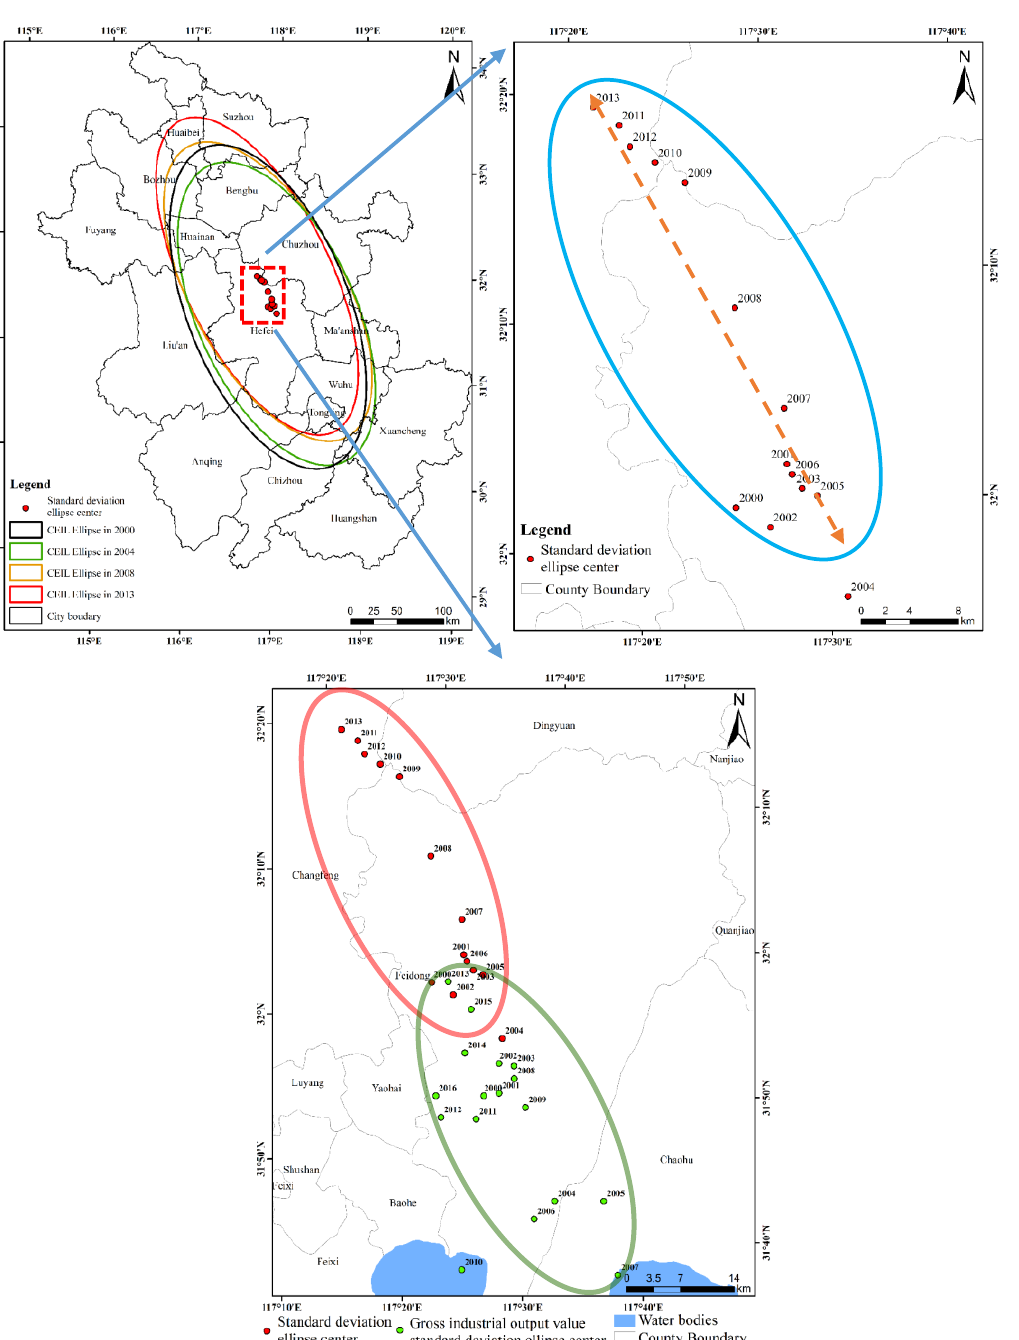
Figure 11. Positional changes in the elliptical center points of GIOV and CEIL standard in Anhui Province from 2000 to 2013.